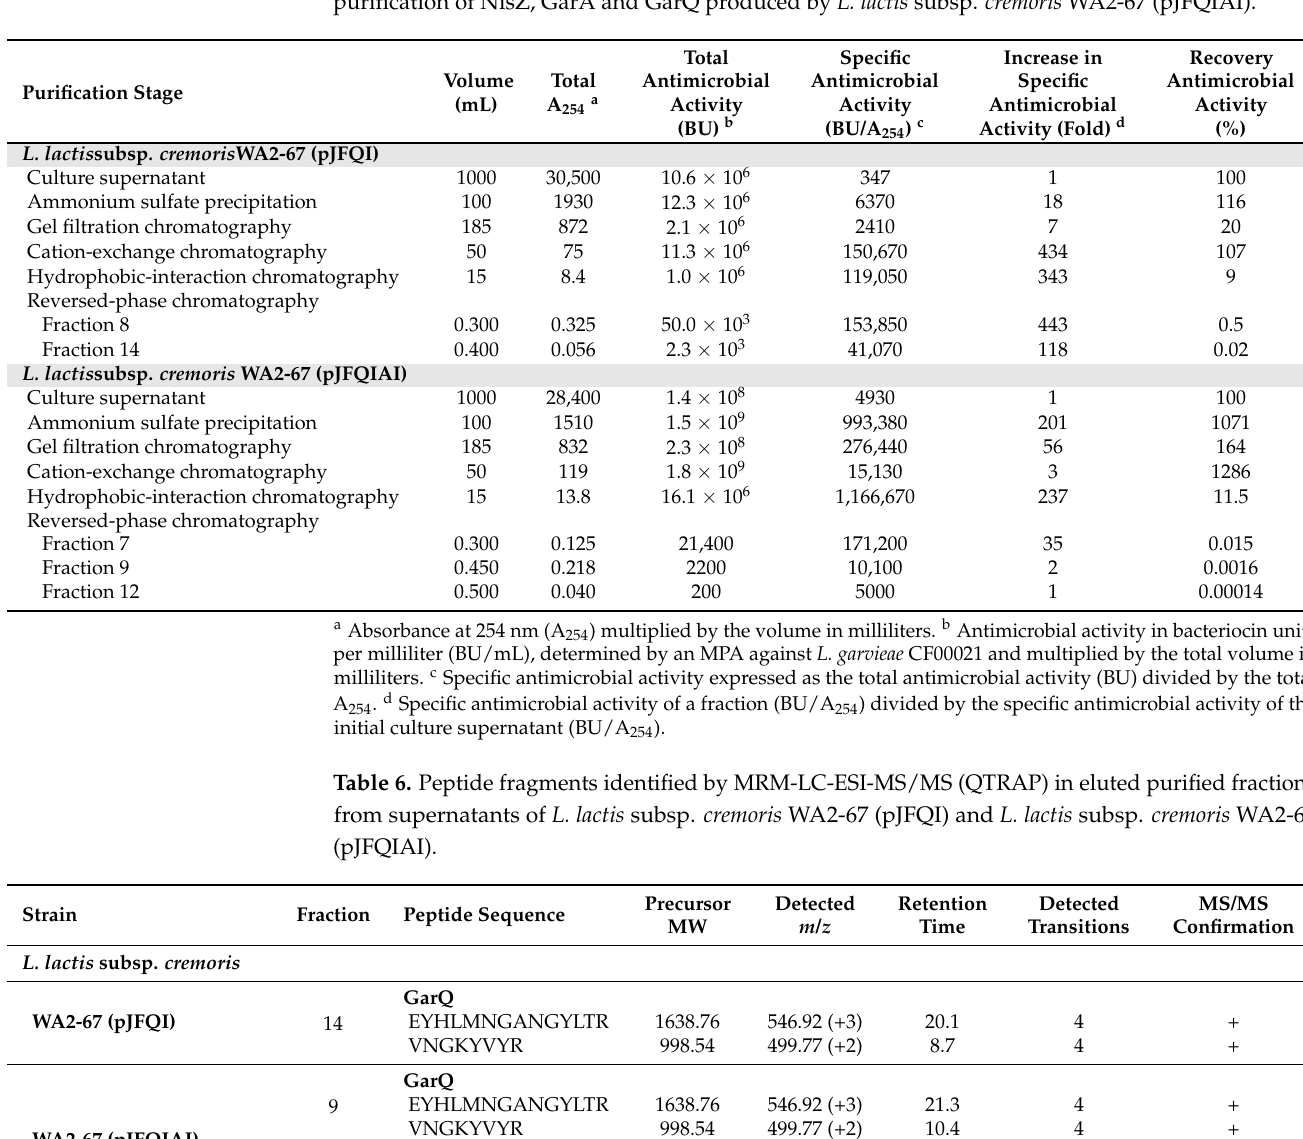
Table 5. Purification of NisZ and GarQ produced by L. lactis subsp. cremoris WA2-67 (pJFQI) and purification of NisZ, GarA and GarQ produced by L. lactis subsp. cremoris WA2-67 (pJFQIAI).